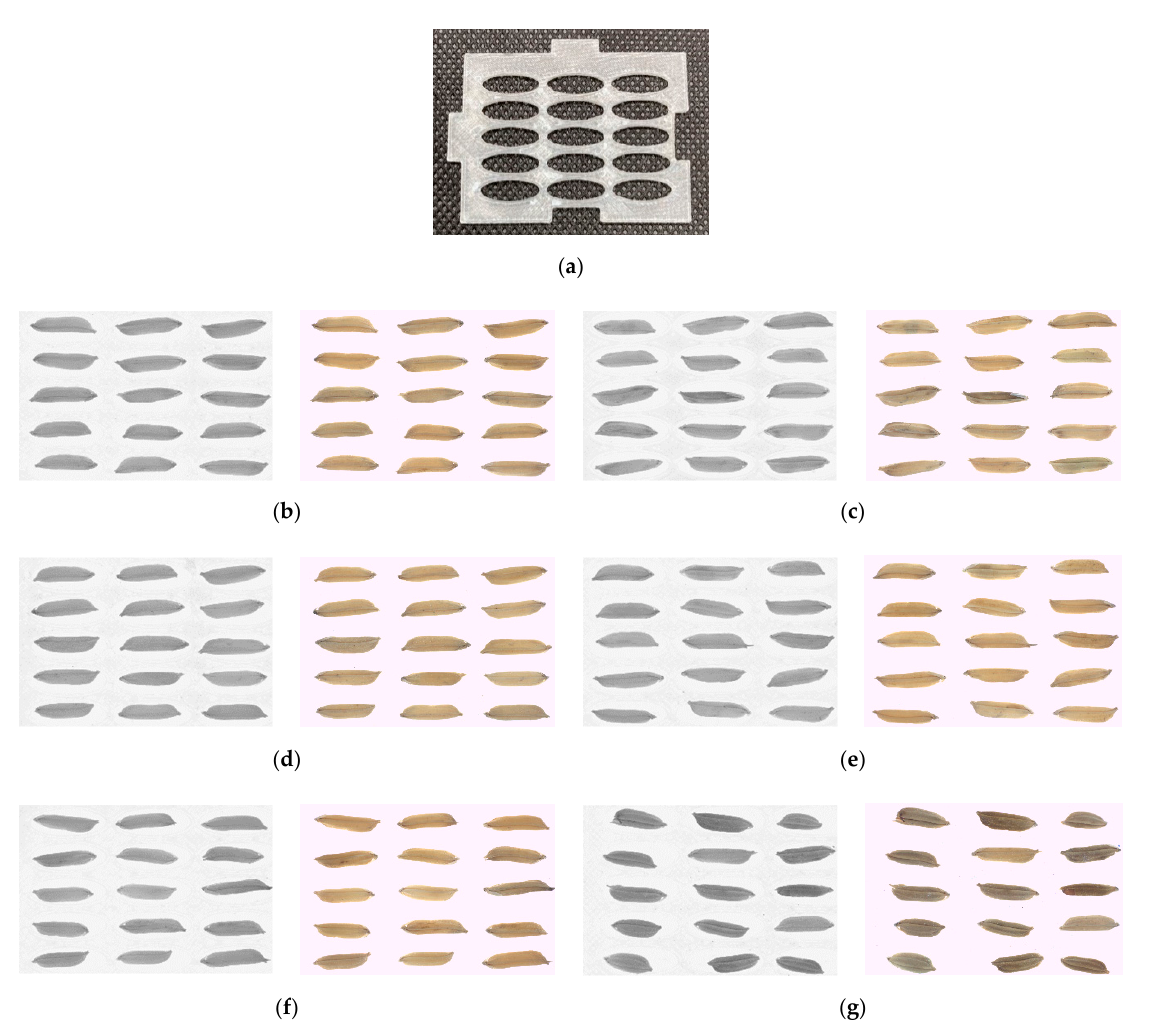
Figure 2. ( a ) Seed holder on black background and sample of the monochrome and RGB images acquired on a seed holder for the five CR varieties i.e., ( b ) MR219 ( c ) MR220CL2 ( d ) MR297 ( e ) UKMRC2 ( f ) UKMRC8 ( g ) and weedy rice variants.